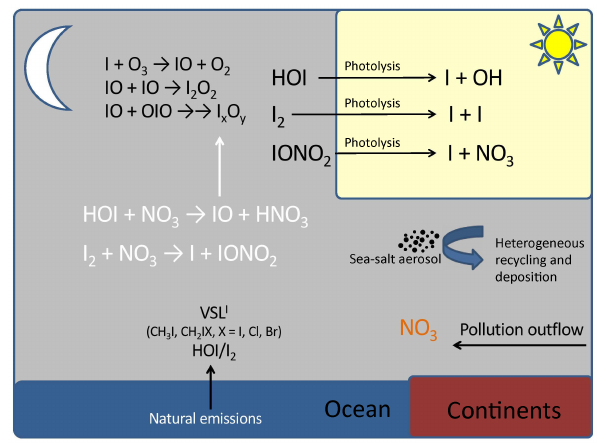
Figure 1. New nocturnal iodine chemistry (in white) implemented in the THAMO and CAM-Chem